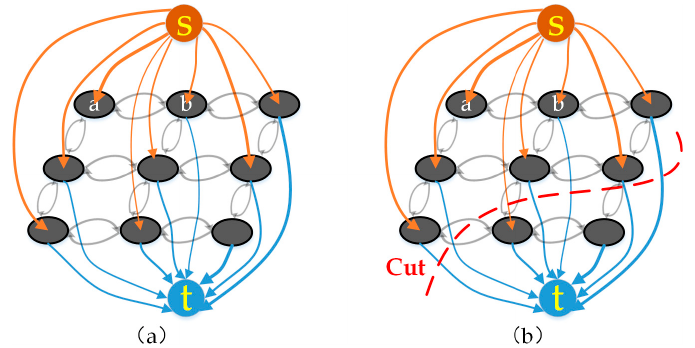
Figure 2. Structure of graph. ( a ) A directed graph structure. ( b ) A cut of the graph. Specific to this paper, graph cuts-based optimal seam-line search is based on the graph structure.